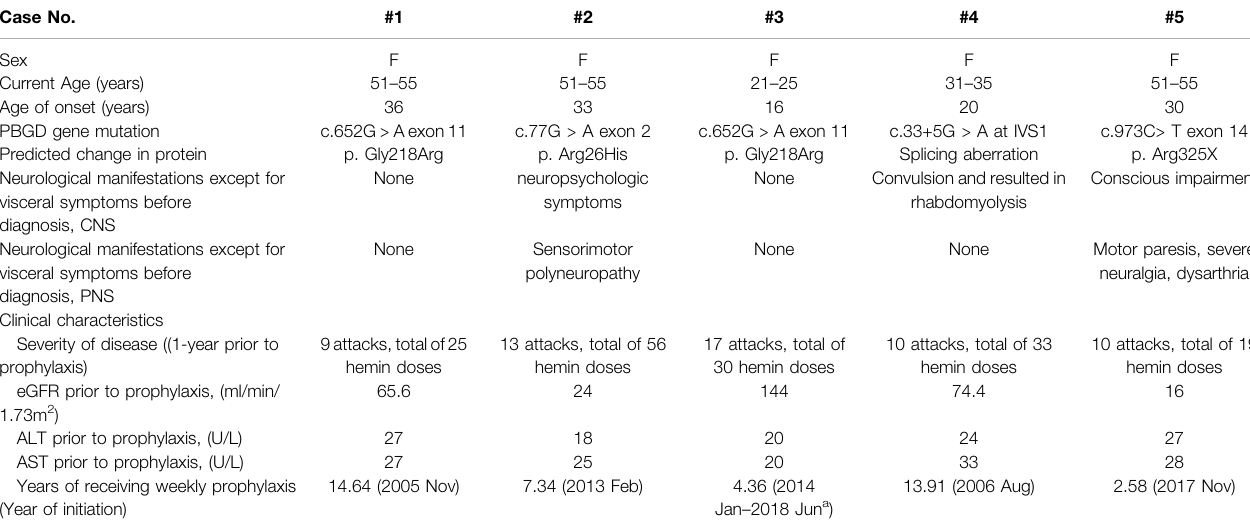
TABLE 1 | Selected demographic and clinical characteristics of AIP patients for period before heme arginate prophylaxis. Case